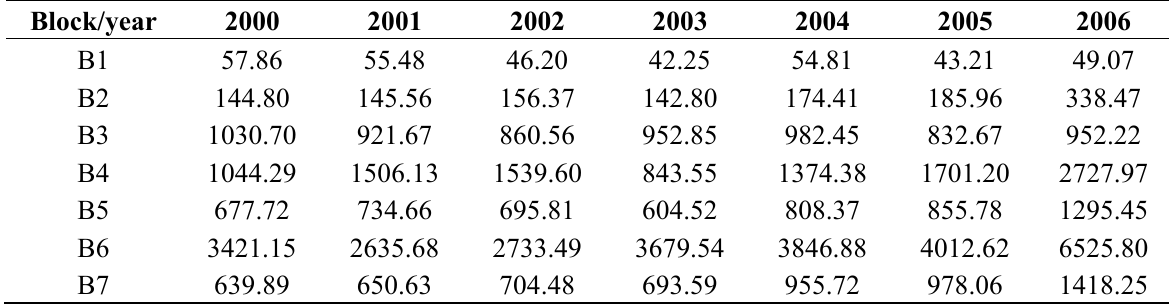
Table 5. Direct/apparent Water Productivity (DWP) in the Castile and León Region, 2000–2006 (€/m 3 , constant prices), urban